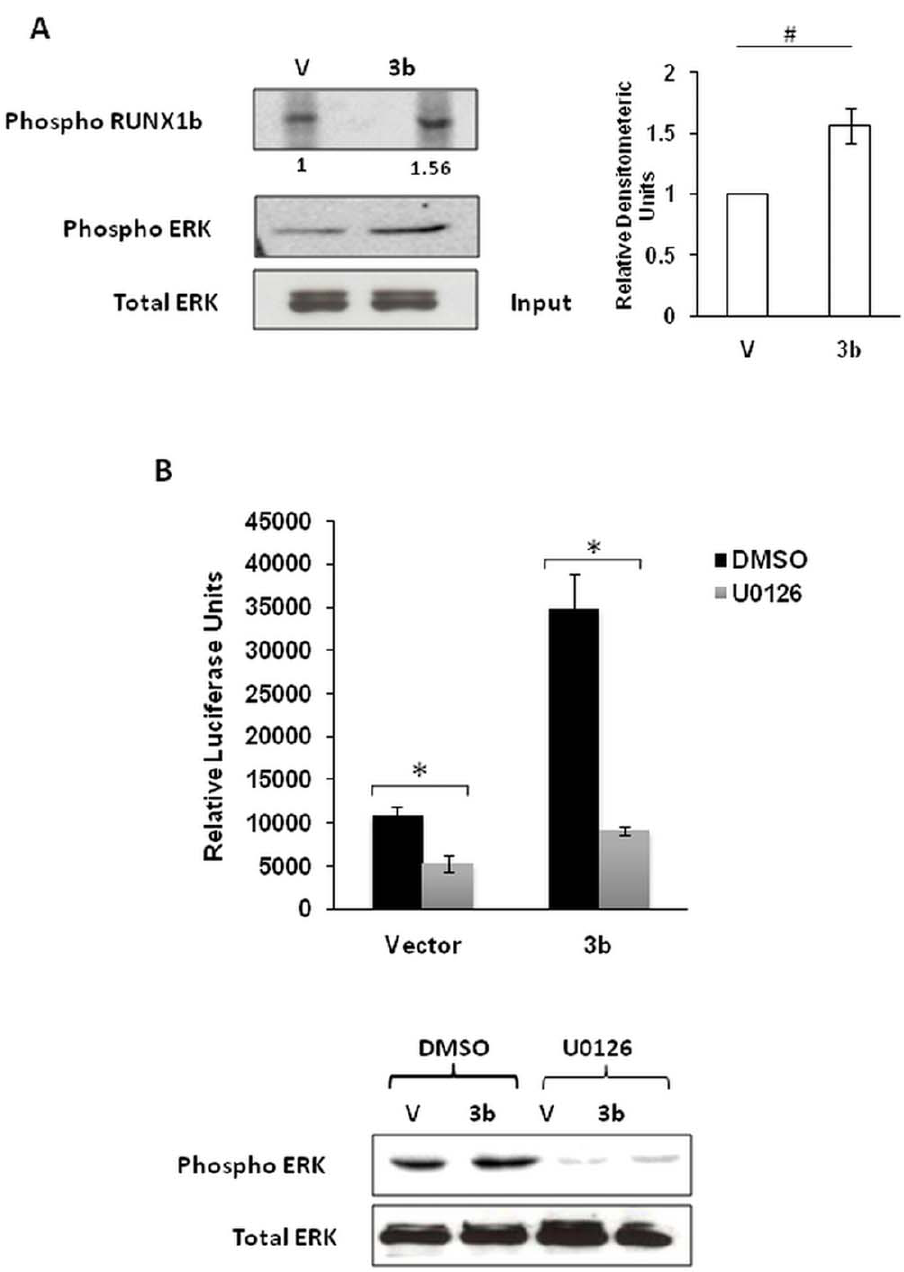
Figure 5. 3b expression increases phosphorylated RUNX1b levels through ERK activation. A. HEK293 cells were transfected with vector, 3b and RUNX1b expression plasmids. ERK immunoprecipitated from vector and 3b lysates were subjected to kinase assay with RUNX1b beads. Phosphorylated RUNX1b was visualized by autoradiography. Input levels of immunoprecipitated ERK and phospho ERK levels in lysates were probed by western blotting. Graph depicts fold increase in the levels of phosphorylated RUNX1b procured after three independent experiments. Bar represents mean 6 SD of values obtained by densitometry. # , p , 0.05. B. Jurkat cells were transfected with WT IL2-Luc in the presence or absence of Myc-3b and treated with DMSO or U0126. Relative luciferase activity was measured and is shown as the mean 6 SD of three independent experiments performed in triplicates. *, p , 0.005. Phospho ERK levels in lysates were probed by western blotting.